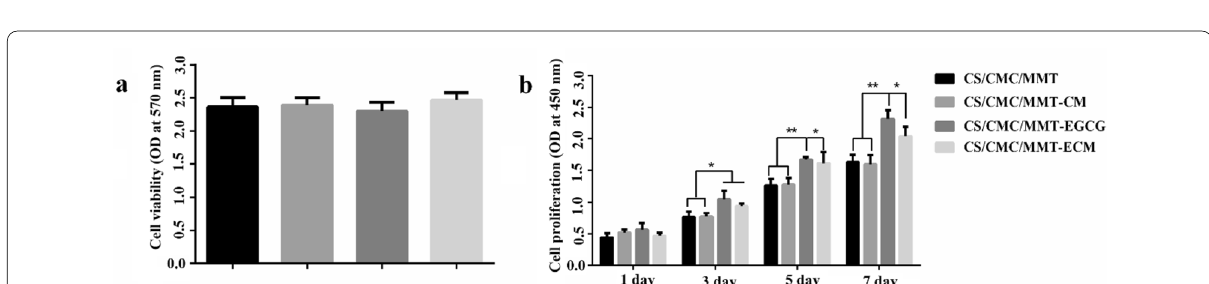
Fig. 7 a The HUMSCs viability in the scaffolds after 48 h observed by MMT assay. b The HUMSCs proliferation in different scaffolds. * P < 0.05, ** P < 0.01 and *** P <